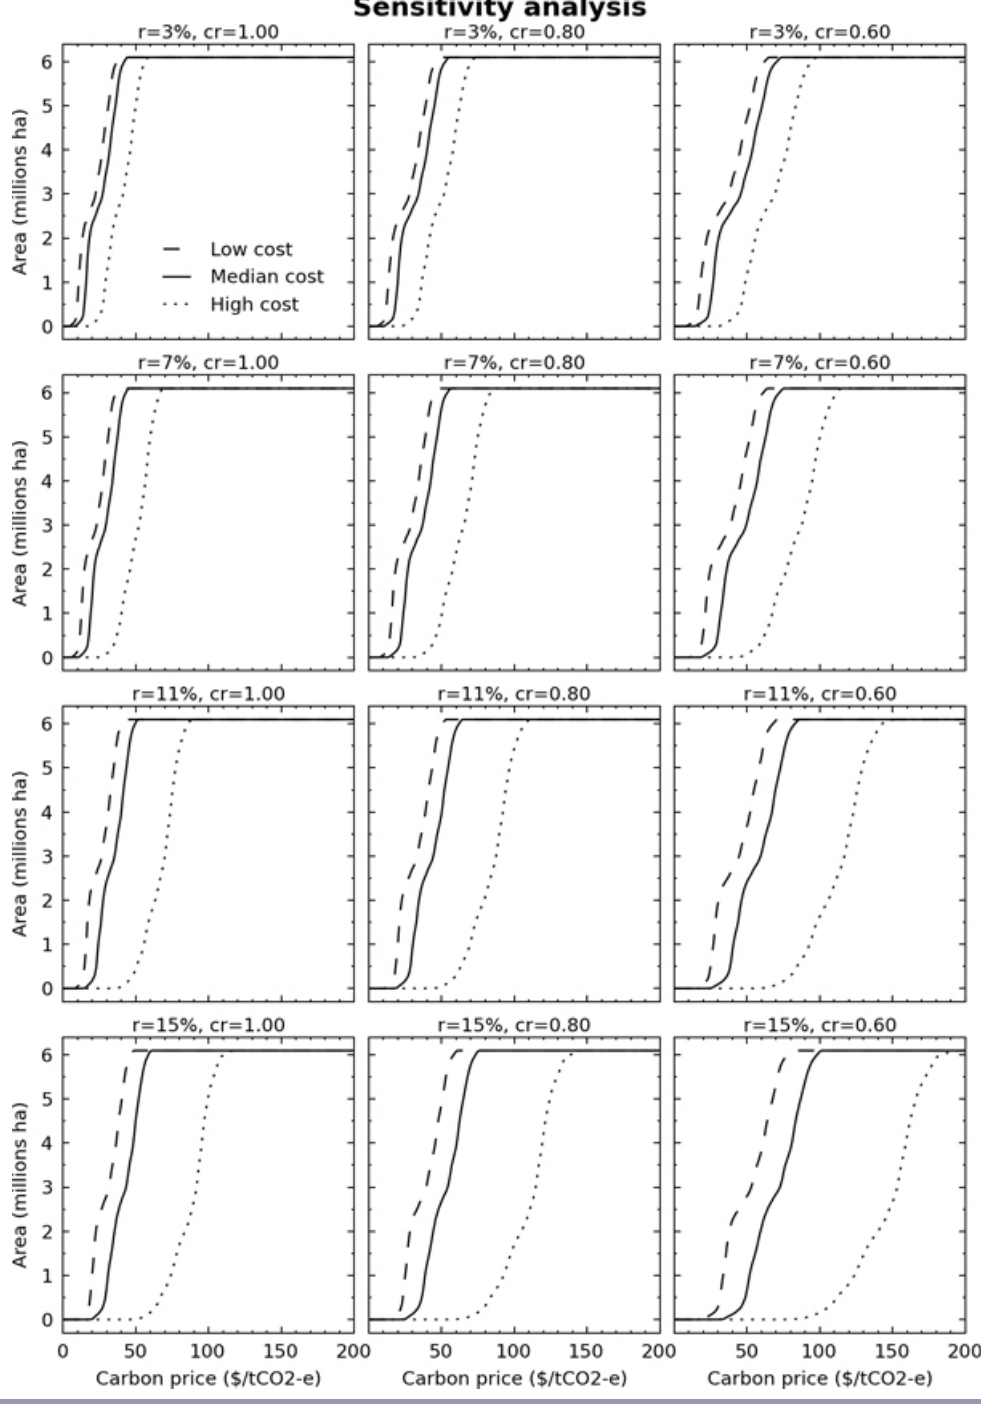
Fig. 6 . Sensitivity of economically viable area for reforestation to variation in carbon risk discounting factor, economic discount rate, establishment costs, and transaction and maintenance costs under the payment per tonne scheme (High cost: ec = A$6000/yr, tmc = A$100/yr; Median cost: ec = A$2000/yr, tmc = A$70/yr; Low cost: ec = A$1150/yr, tmc =